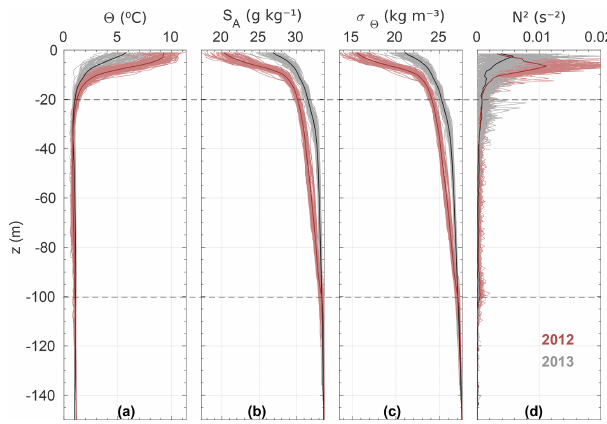
Figure 5. (a) Conservative temperature, (b) absolute salinity, (c) sigma–theta (potential density – 1000kgm − 3 ) and (d) squared Brunt–Väisälä frequency profiles (Eq. 1) derived from CTD casts in Saqqarleq fjord during field surveys in July 2012 (red) and 2013 (grey). Averaged profiles are shown as darker lines and are used as ambient boundary conditions for the line plume model. Casts from inside the plume are not included here. Note that the water column is characterized in three layers separated by dashed horizontal